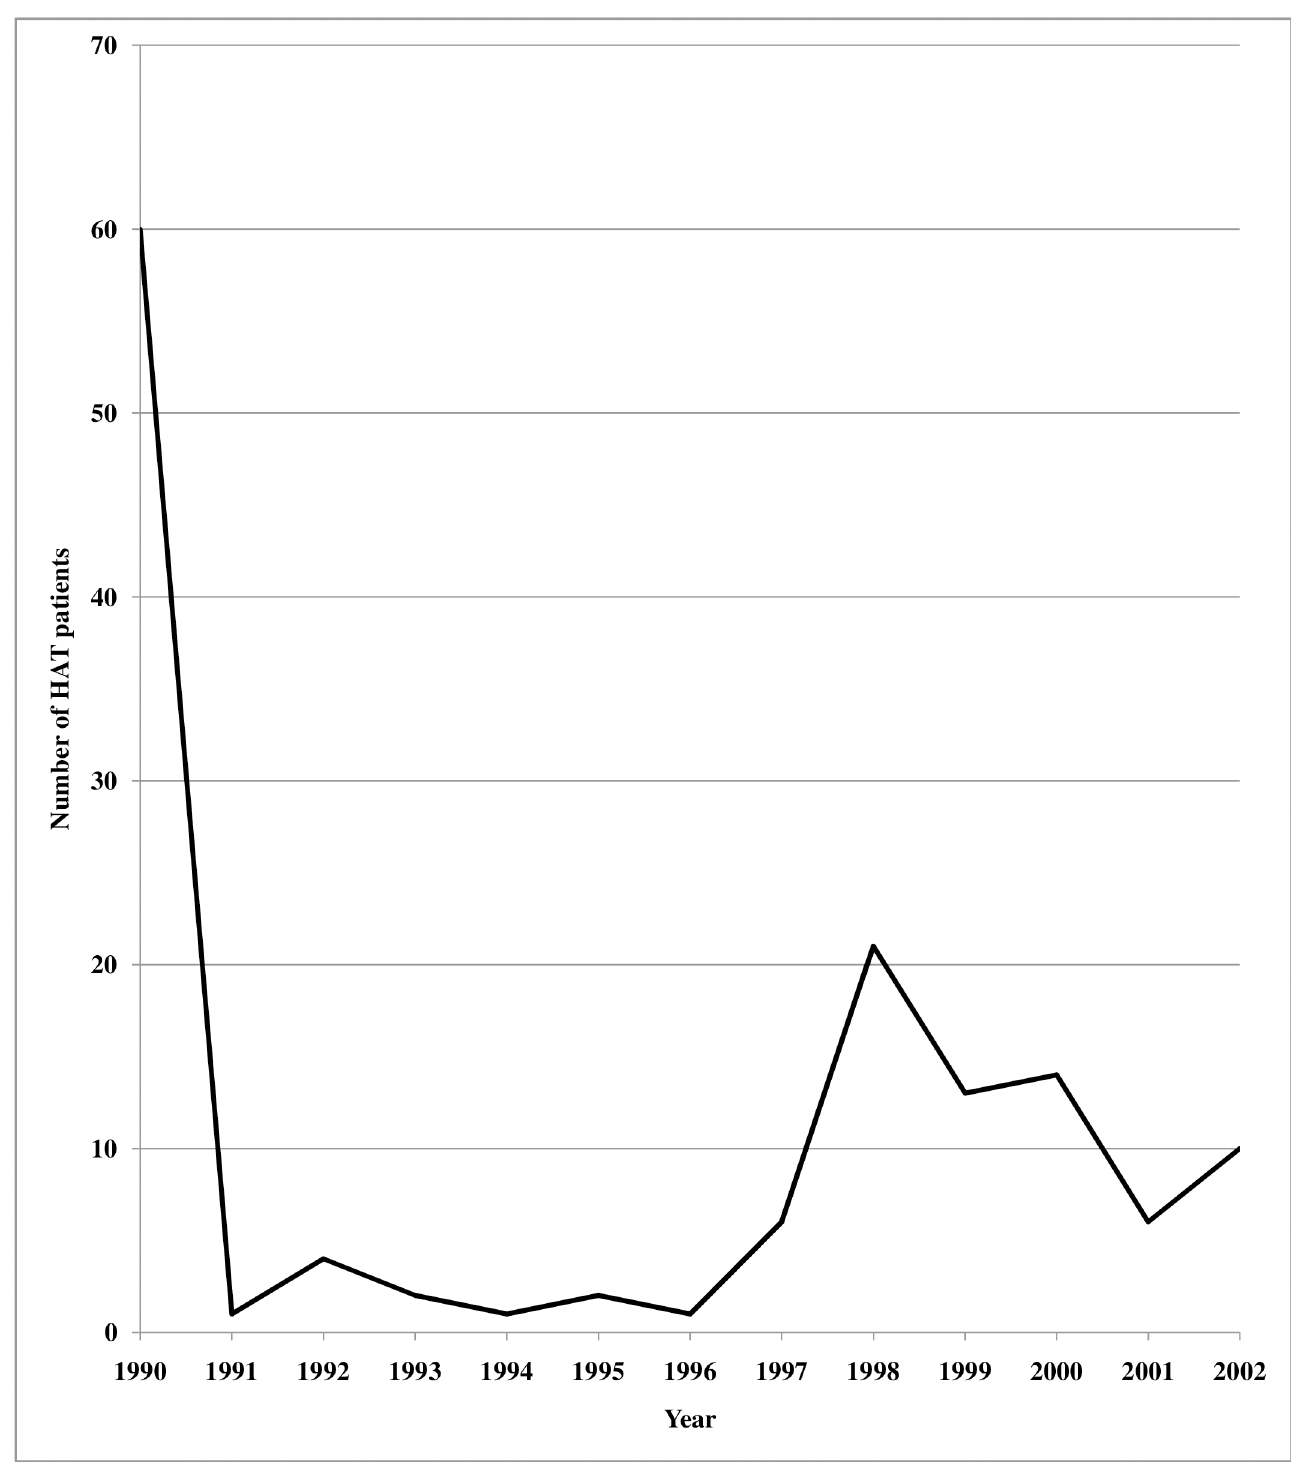
Fig 1. Trends in HAT patients in the south western Kenya HAT foci (1990–2002).